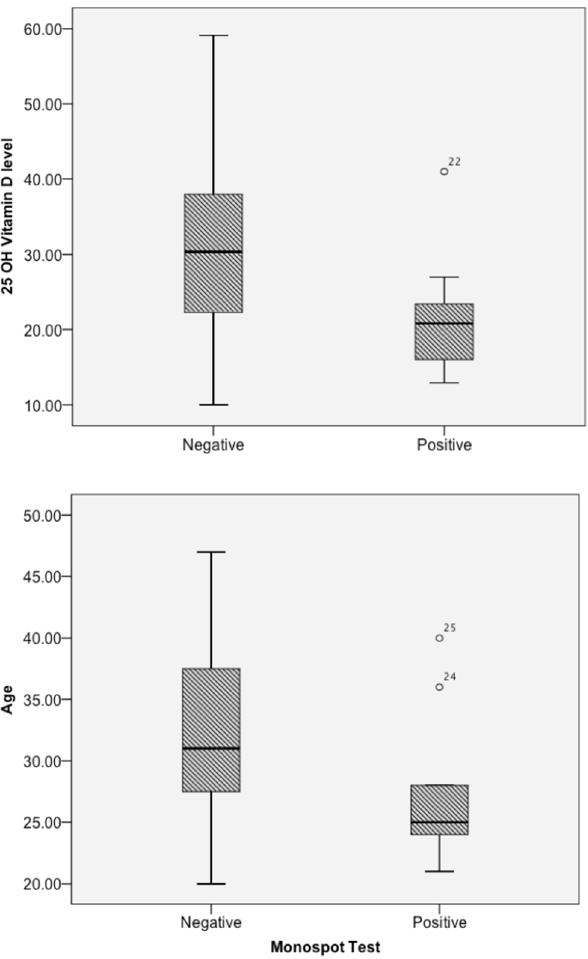
Figure 1. Boxplots comparing Serum 25 OH vitamin D 3 levels (upper panel) and age (lower panel) between those with acute pharyngitis who test positive and negative on the monospot